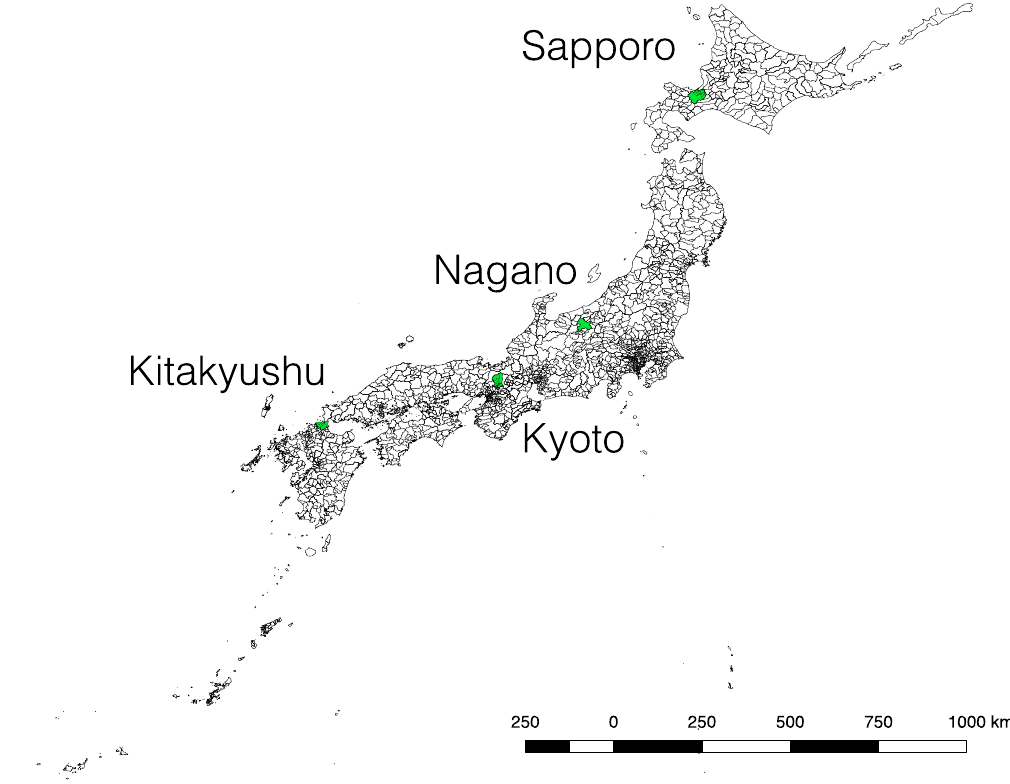
Figure 1. Location of the four targeted shrinking cities in Japan (green).